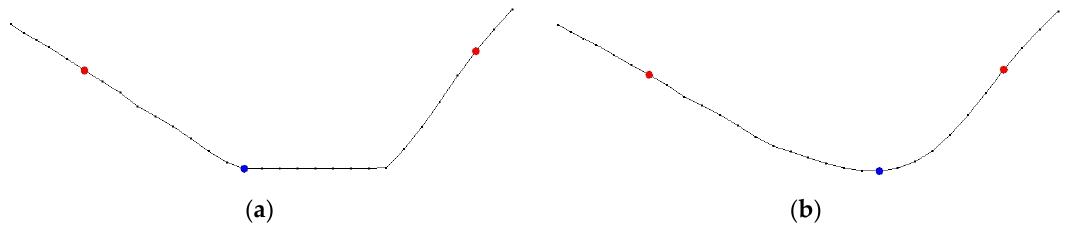
Figure 28. Explanation of automatic channel bed restoration feature: ( a ) before; and ( b ) after restoration.